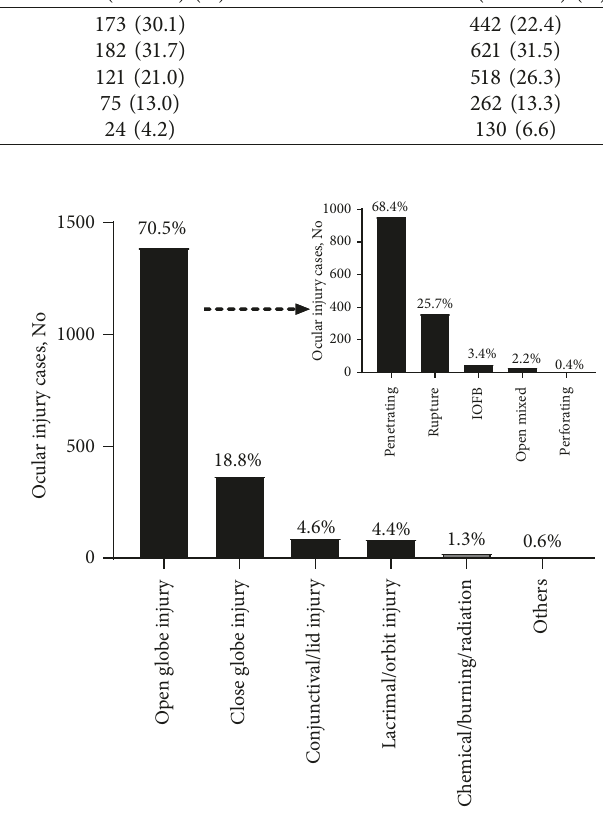
Figure 3: Details of pediatric ocular trauma caused by the type of injury from 2019 to 2020.